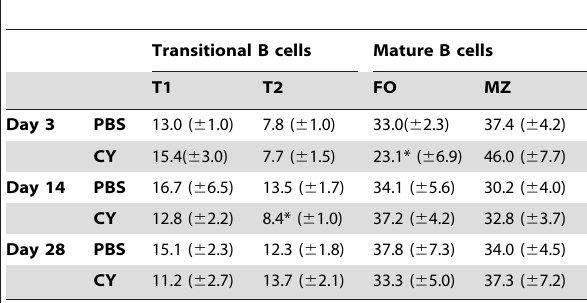
Table 4. Percentage of IgG2b + B cells of R4A Tg mice following treatment with CY.